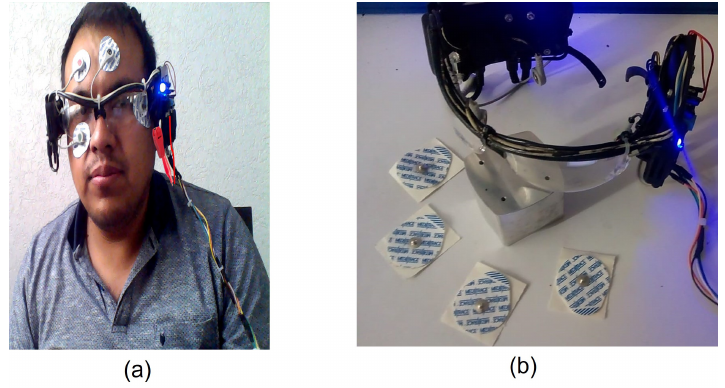
Figure 5. ( a ) Correct placement of the electrodes near the eyes, in the ear lobe and on the forehead. Six electrodes are used for horizontal and vertical movement signals. ( b ) Glasses designed to acquire the EOG signal, the system allows the correct placement of the electrodes on the face for signal acquisition.